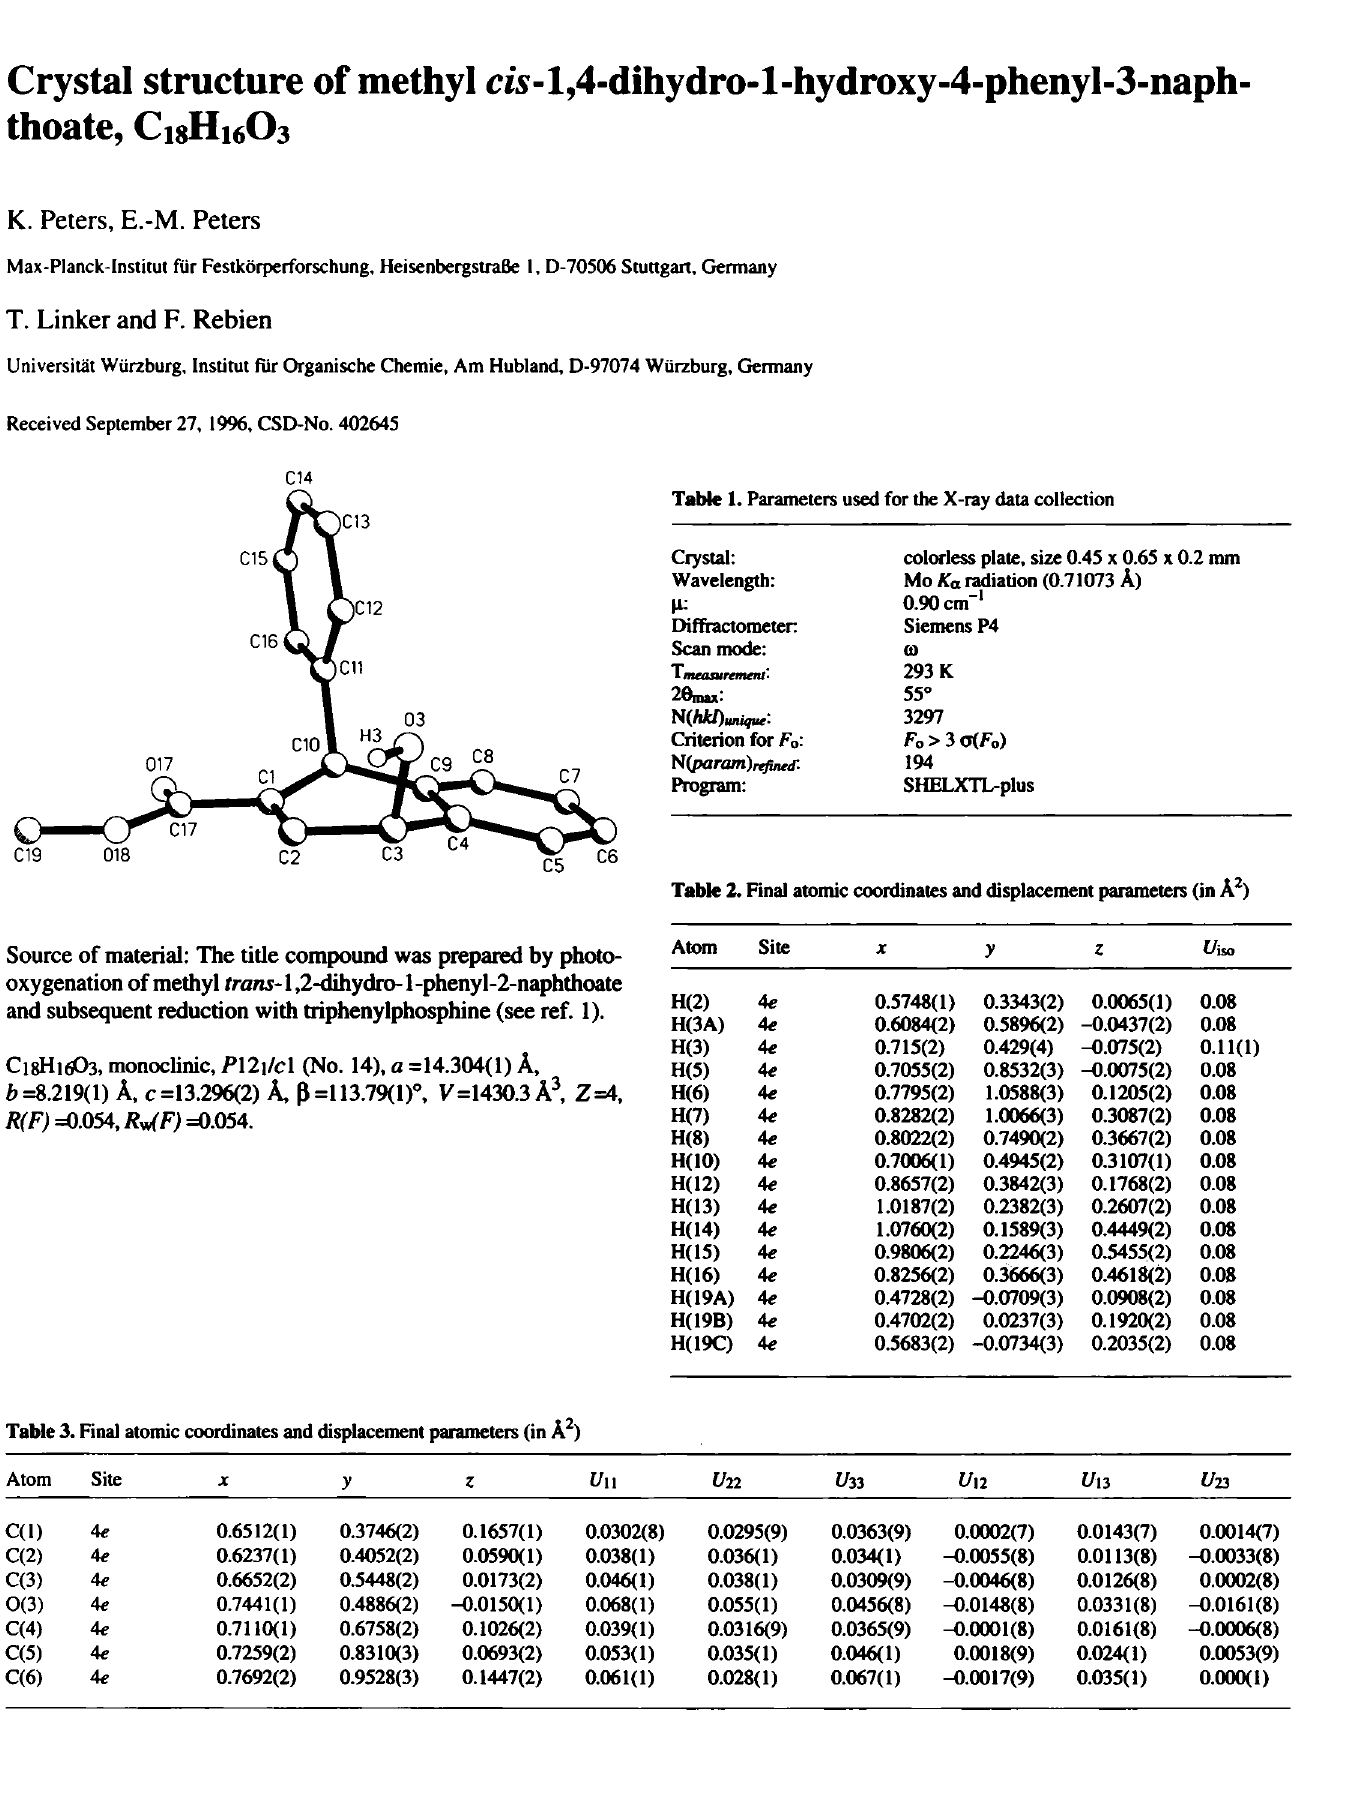
Table 1. Parameters used for the X-ray data collection